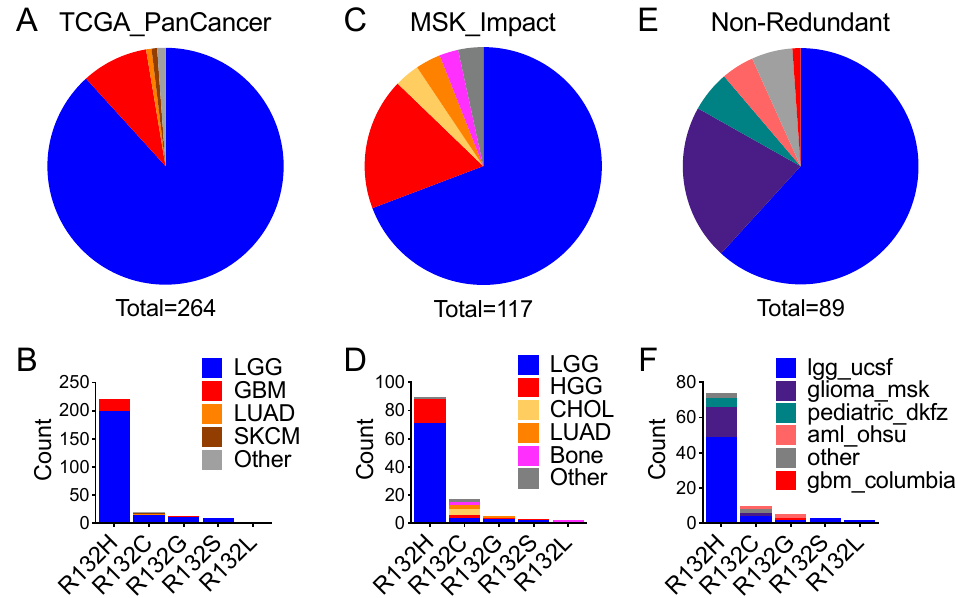
Figure 3. Co-occurrence of IDH1 hotspot mutation and TP53 alteration is predominantly in glioma. Analysis of TCGA_PanCancer ( A , B ), MSK_Impact ( C , D ), and Non-Redundant ( E , F ) datasets reveals co-occurrence of IDH1 hotspot mutations and TP53 alterations overwhelmingly in glioma and rarely in other cancer types, as presented in pie charts (top) and column charts (bottom) where sample counts of the cancer types are in reference to specific types of IDH1 mutation. Of note, the cancer types in pediatric_dkfz ( F ) are high-grade glioma.